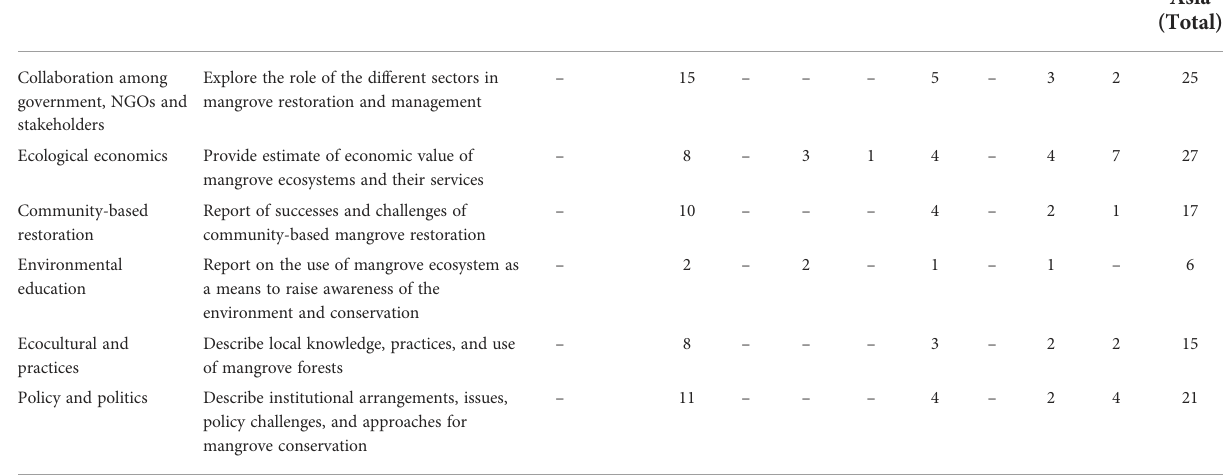
TABLE 6 Commonly examined social dimensions in mangrove restoration studies from each country and in Southeast